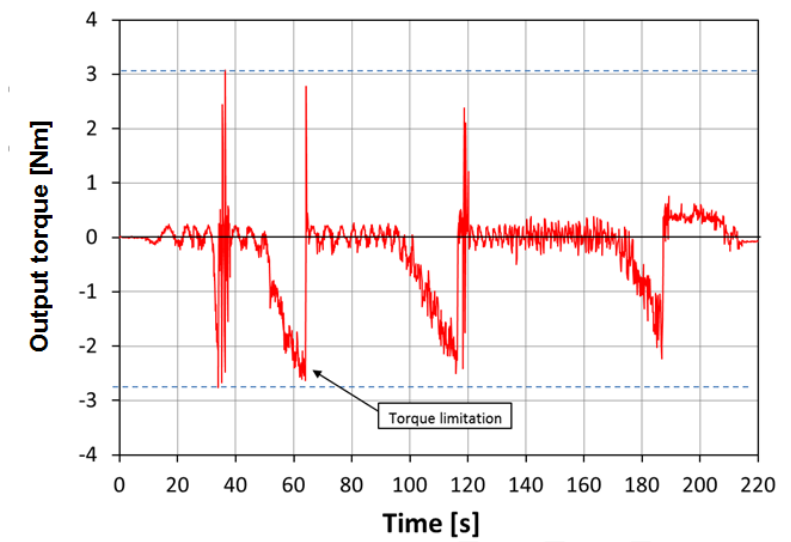
Figure 13. Output torque measurement.